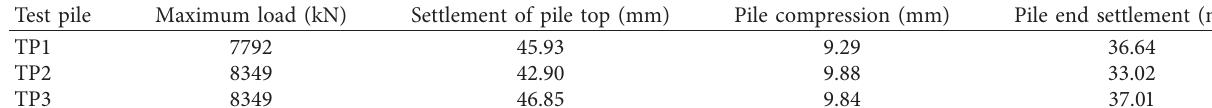
Table 4: Results of static load test on each test